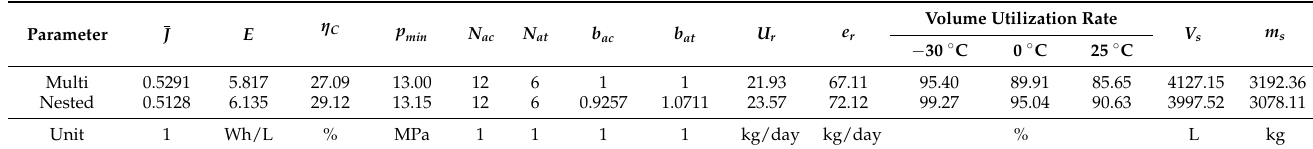
Table 6. Multi-objective comprehensive scheme and nested optimal